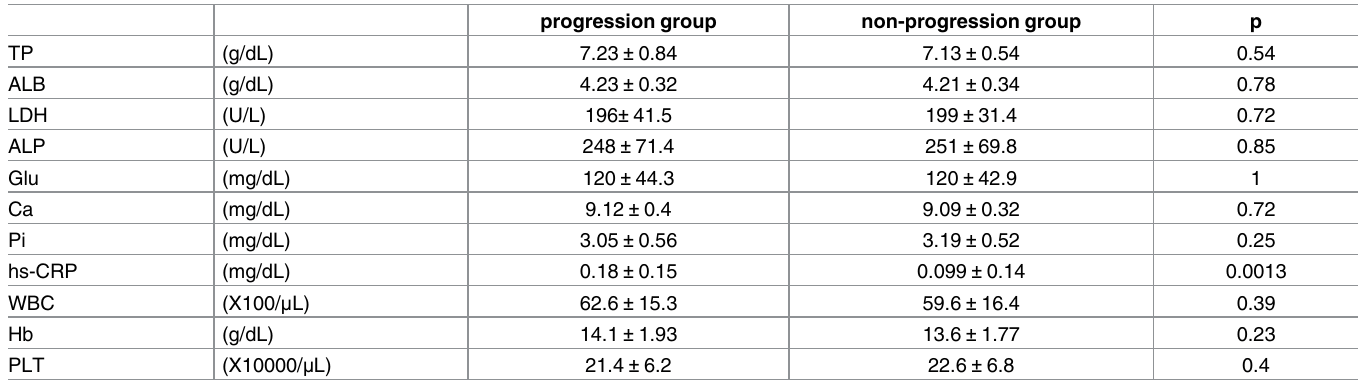
Table 4. Comparison of the biomarkers betweeen the progression group and the non-progression